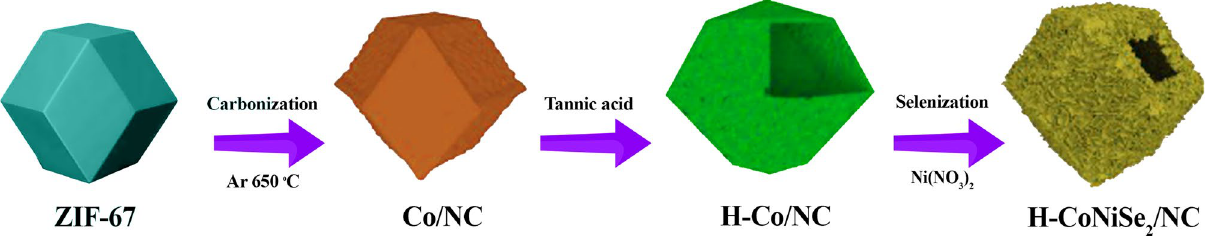
Figure 1. Schematic of H-CoNiSe 2 /NC